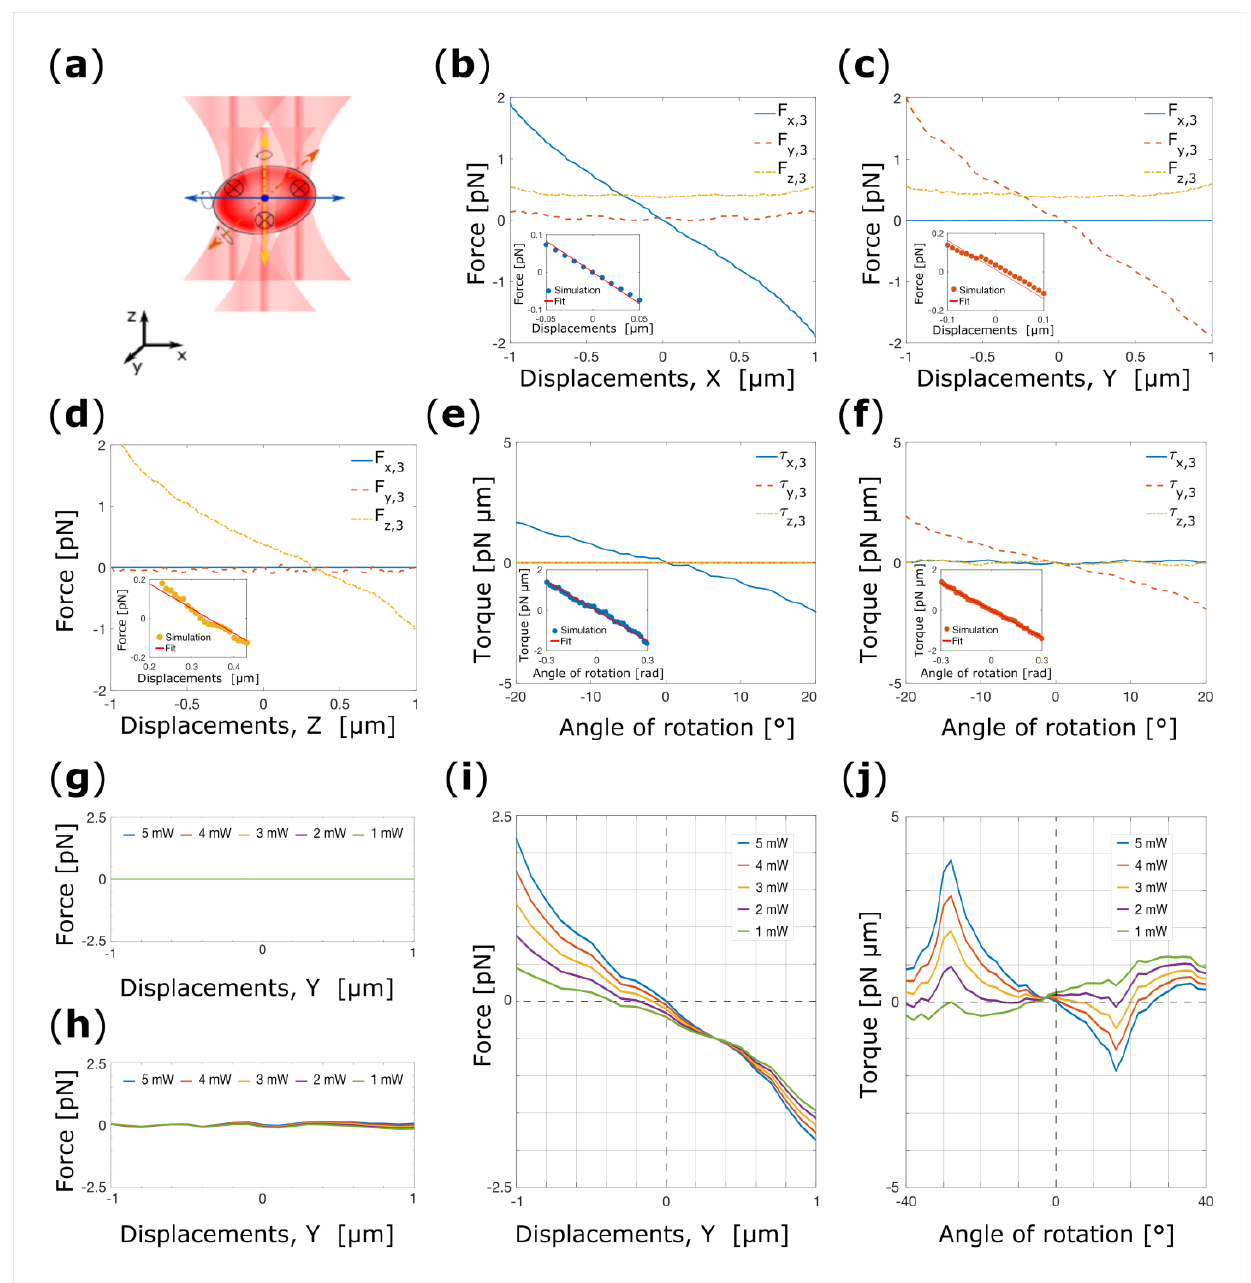
Figure 5. ( a ) Schematic representation of the triple-beam optical tweezers. The arrows indicate the possible translations and rotations of the cell. Cartesian components of the total optical force acting on the center of mass of the RBC as a function of the cell’s displacements from the center of the trap along x ( b ), y ( c ) and z ( d ). Torque-rotation curves for cell rotation around x ( e ), and y ( f ). The inserts show the linear fit to the approximately linear portion of the force-displacements and torque-rotation curve. Force-displacements curves for cell displacements along the x -direction ( g ), z -direction ( h ), and y -direction ( i ) while in ( j ) is reported the torque-rotation curves. In ( g – j ) the power of the beam on the vertex positioned over the y -axis is decreased sequentially from 5 mW to 1 mW.